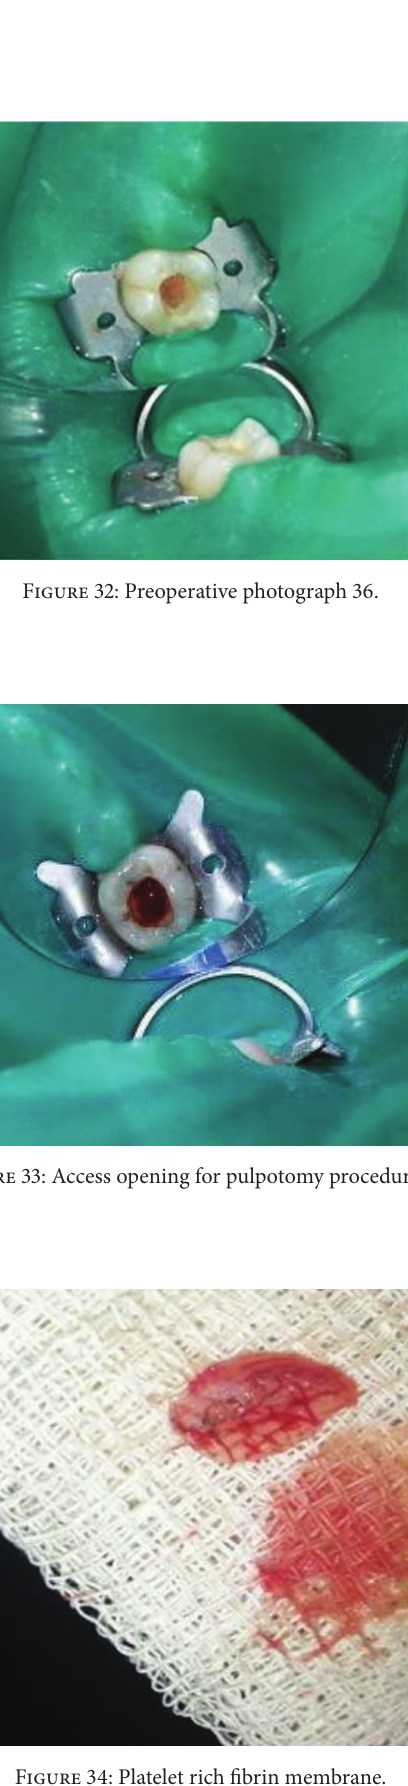
Figure 31: 9-month followup RVG 36.